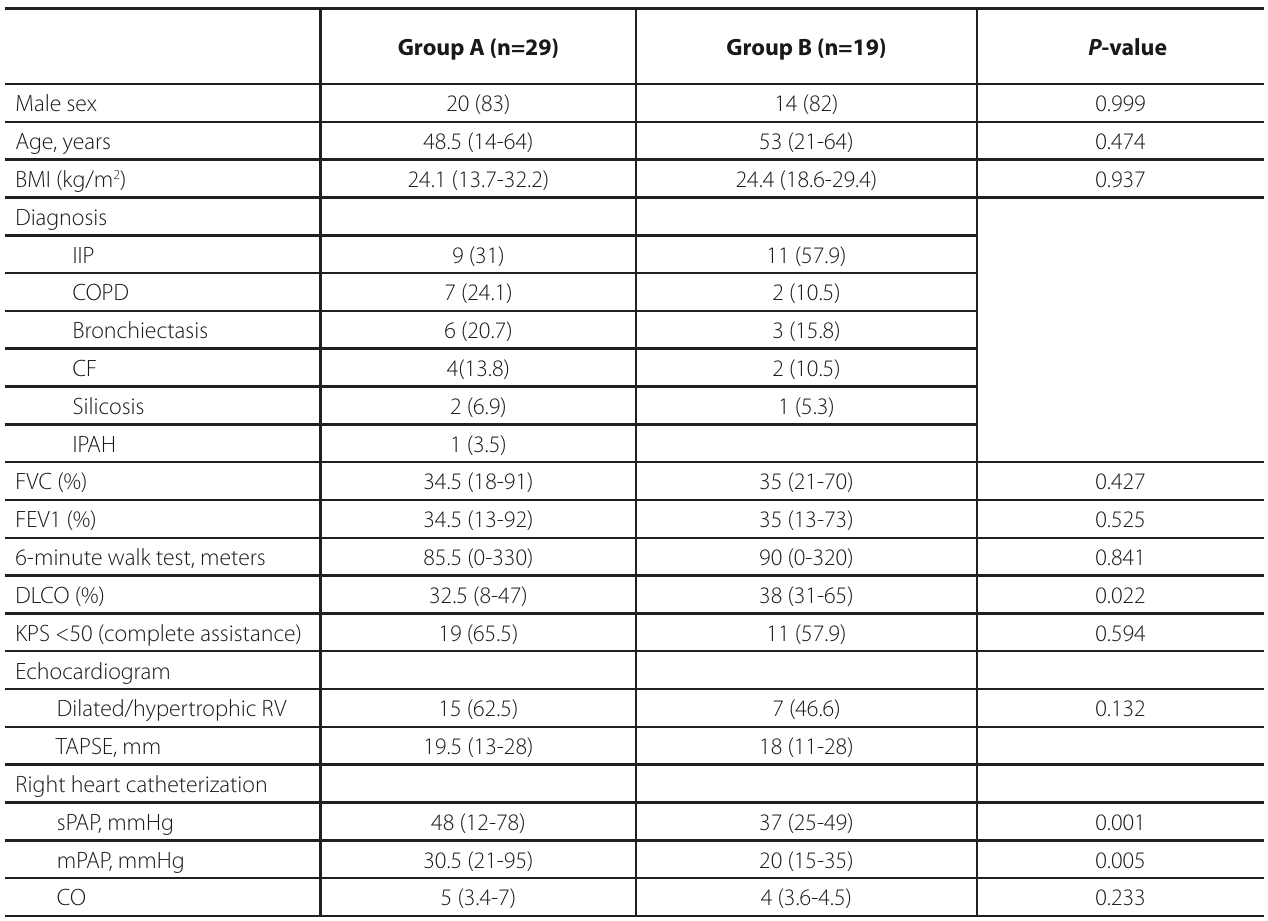
Table 1. Patient